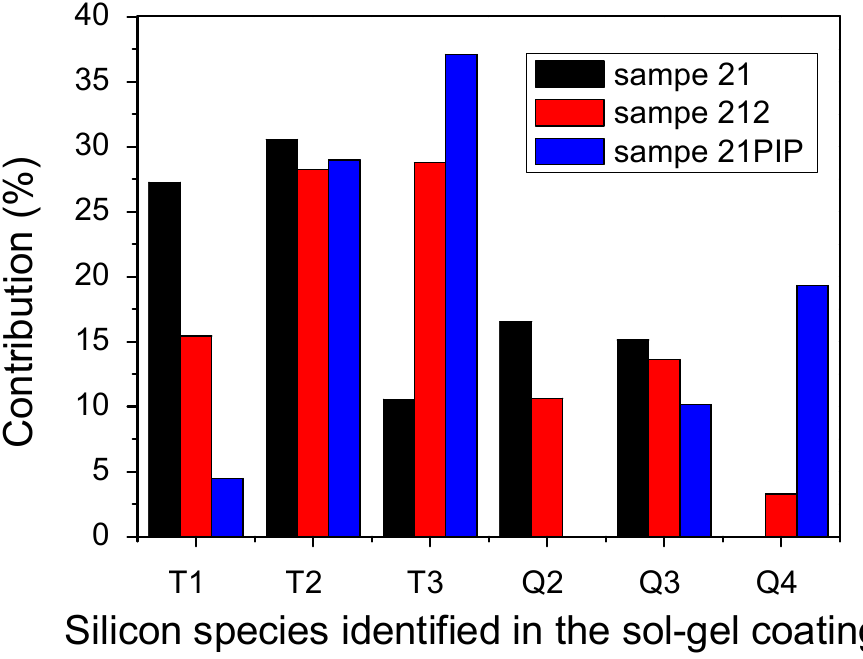
Figure 9. Relative proportions (%) of di ff erent T and Q silicon units identified by 29 Si-NMR spectroscopy Figure 9 . Relative proportions (%) of different T and Q silicon units identified by 29 Si-NMR for 21 and 212 and 21PIP spectroscopy for 21 and 212 and 21PIP samples.